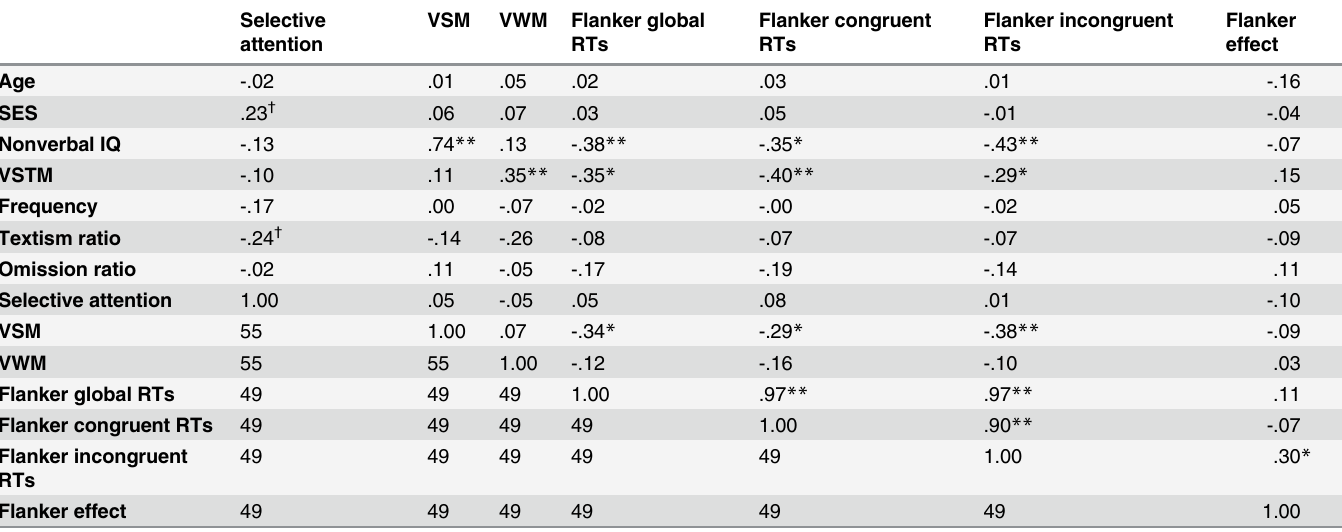
Table 12. Correlation matrix of children ’ s performance on the executive functions